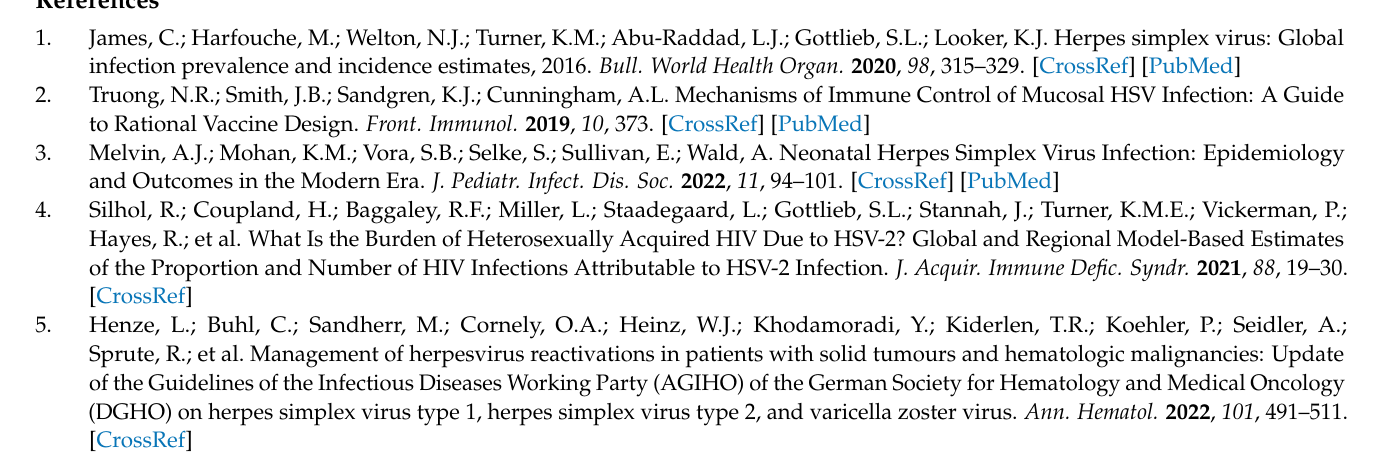
Figure S2: VIT encoded cDNA, Figure S3: RNA expression of VLM and VIT genes in human